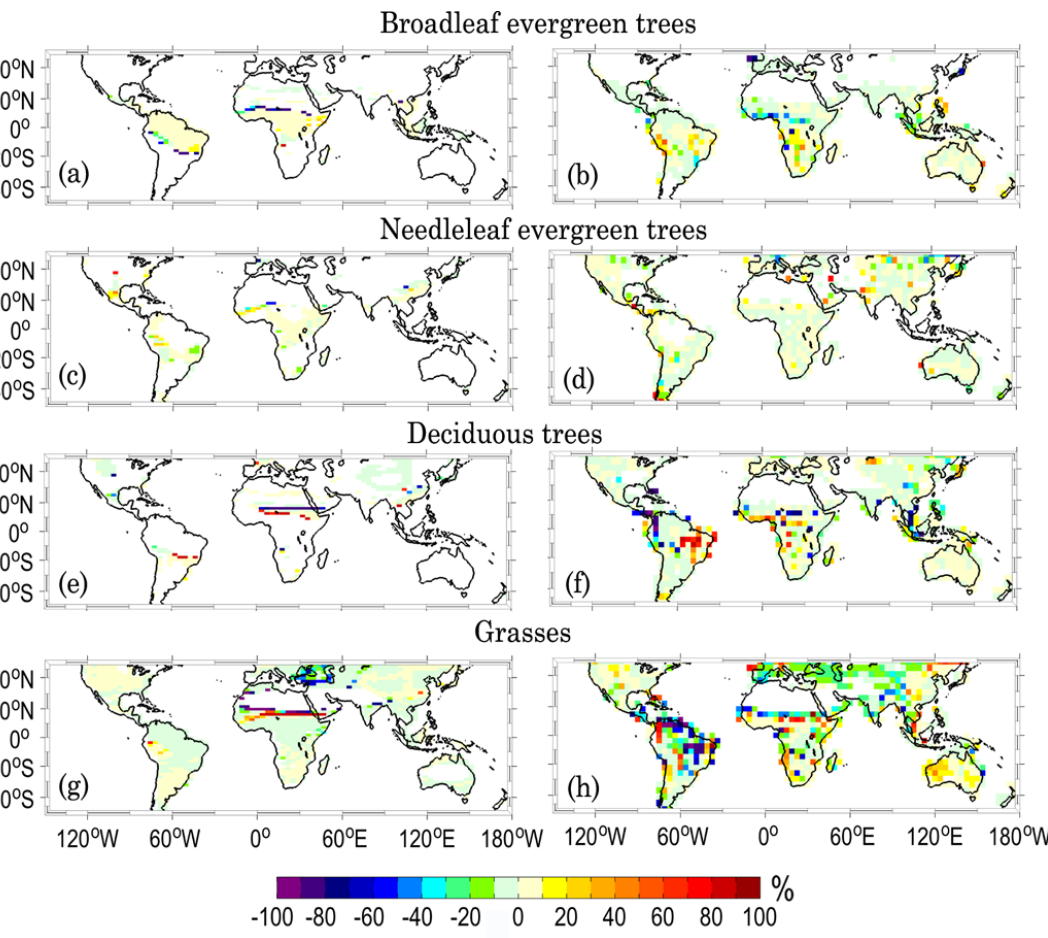
Fig. 2. Annual mean differences of PFT cover between HE1 and LGM simulations for the UVic ESCM (left panels) and the CCSM3 (right panels). The classification into the four PFTs is defined in Table